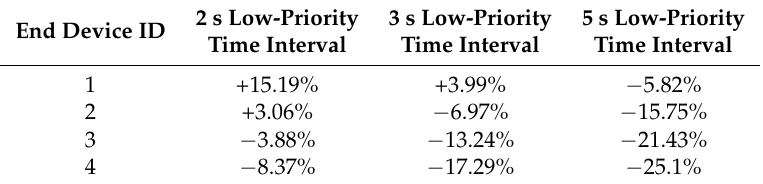
Table 3. Comparison of the two simulation modes without